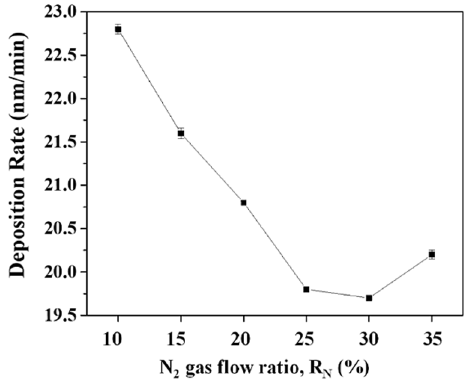
Figure 3. Deposition rate of the Mo–Si–N coatings deposited at various N 2 gas flow ratios from 10% to 35%, retaining the working pressure of 10 mTorr.